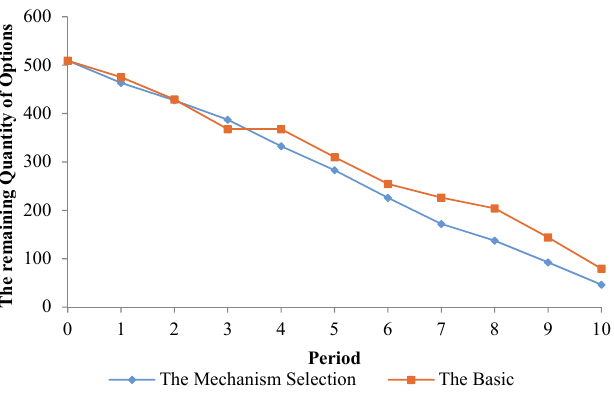
Fig. 2. Th remaining of the options in the basic model and the mechanism selection model